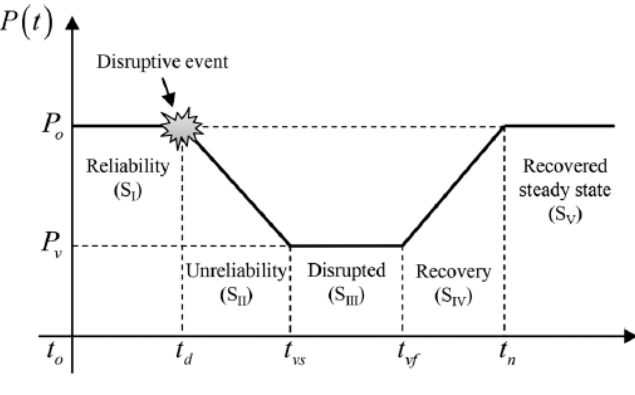
Figure 2. Engineering resilience curve [21].